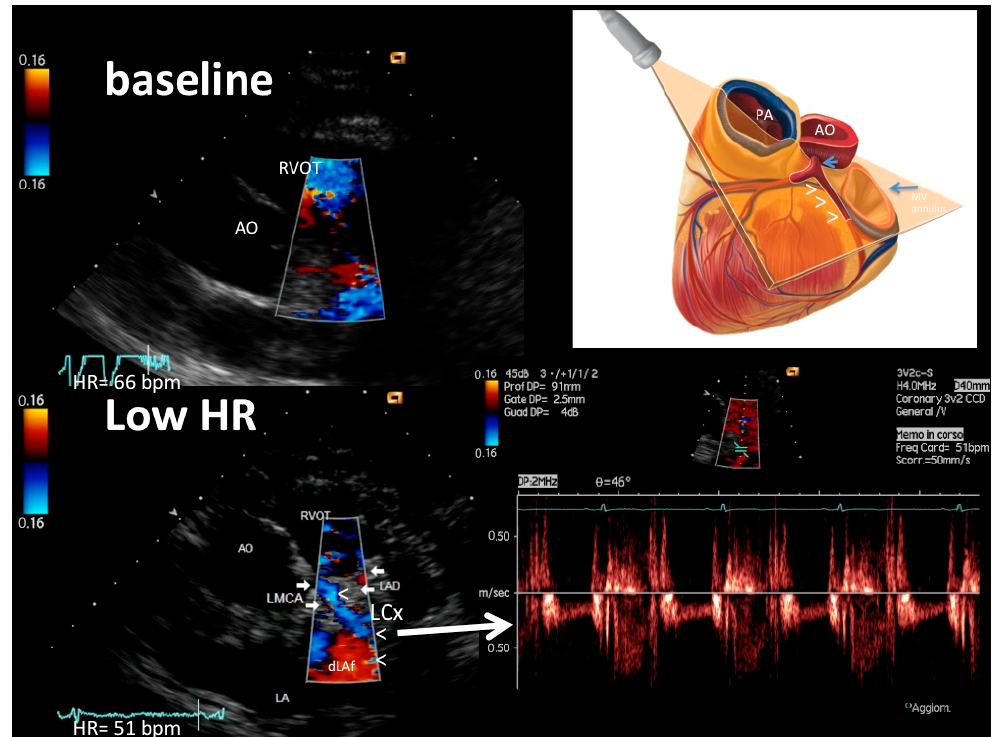
Figure 2. An example of LMCA, proximal–mid LCx and proximal LAD color flow (plane orientation at the top right corner) at higher HR (66 b/m) (upper left) and after HR reduction (51 b/m) (bottom right): at the baseline with higher HR, no coronary flow is detected; after HR lowering (<60 b/m), optimal color signal is recorded in the LMCA (arrows), LCx (arrowheads) and very proximal LAD (arrows, signal in red); thanks to good color guidance optimal pulsed-wave Doppler quality in LCX is obtained (bottom right). The color signal is coded in blue both in LMCA and LCx and the LCx PW tracing is below the zero line because flow is away from the transducer. In the schematic cartoon (top right), the arrowheads indicate the LCx, the long arrow the mitral annulus and the short arrow the LMCA. LMCA = left main coronary artery color flow; LAD = proximal LAD color flow; LCx = proximal–mid left circumflex coronary artery color flow; RVOT = right ventricular outflow tract; pv = pulmonary valve; Ao = aorta; LA = left